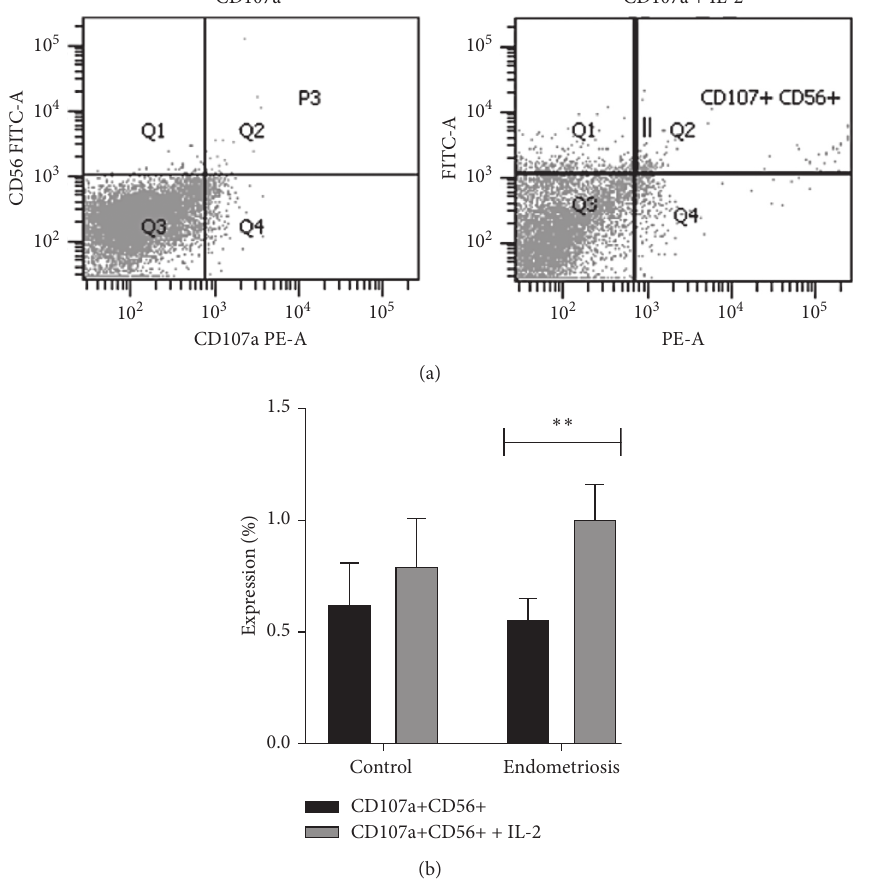
Figure 1: Upregulation of CD107a expression by IL-2 stimulation. (a) Flow cytometry analysis of the CD107a population without and with IL-2. (b) Comparison of CD107a expression before and after IL-2 stimulation in the control group and the endometriosis group. The differences before and after IL-2 stimulation were analyzed by paired t -test. ∗∗ p < 0.01 was considered to indicate a significant difference.